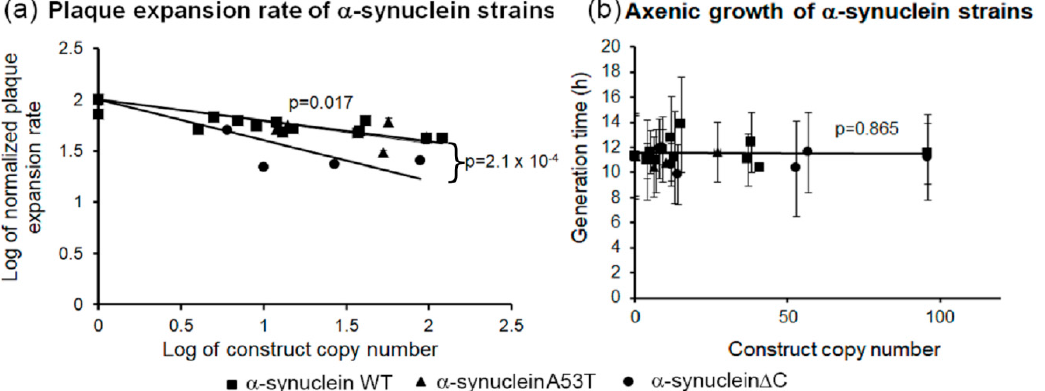
Figure 5. α -synuclein a ff ects growth on bacterial lawns but not in liquid media. ( a ) The plaque expansion rates by the α -synuclein-expressing strains plotted against the α -synuclein construct copy number. The tested strains were grown on E. coli B2 lawns on SM agar and the plaque expansion was measured over one hundred hours. Experiments were performed in triplicate in three individual experiments. Α lpha-synuclein WT and the point mutant strains showed slower growth compared to the parental strain but were not significantly different from each other, the α -synuclein Δ C strains showed an even slower growth compared to the parental strain. Error bars represent standard errors of the mean. The regression was significant at indicated p values ( t -test). The lines were fitted by the least squares method to a linear equation. ( b ) The growth rate in liquid media of strains expressing α -synuclein was plotted against the α -synuclein construct copy number. The strains were grown in HL-5 medium in shaken cultures at 21 ◦ C and the generation times (doubling time during exponential growth) were measured. Experiments were performed in duplicate in each of two separate experiments. Neither the α -synuclein WT nor the mutant forms caused adverse e ff ects on growth in liquid. Error bars represent standard errors of the mean. The regression was not significant as indicated by the p value. The line was fitted by the least squares method to a linear